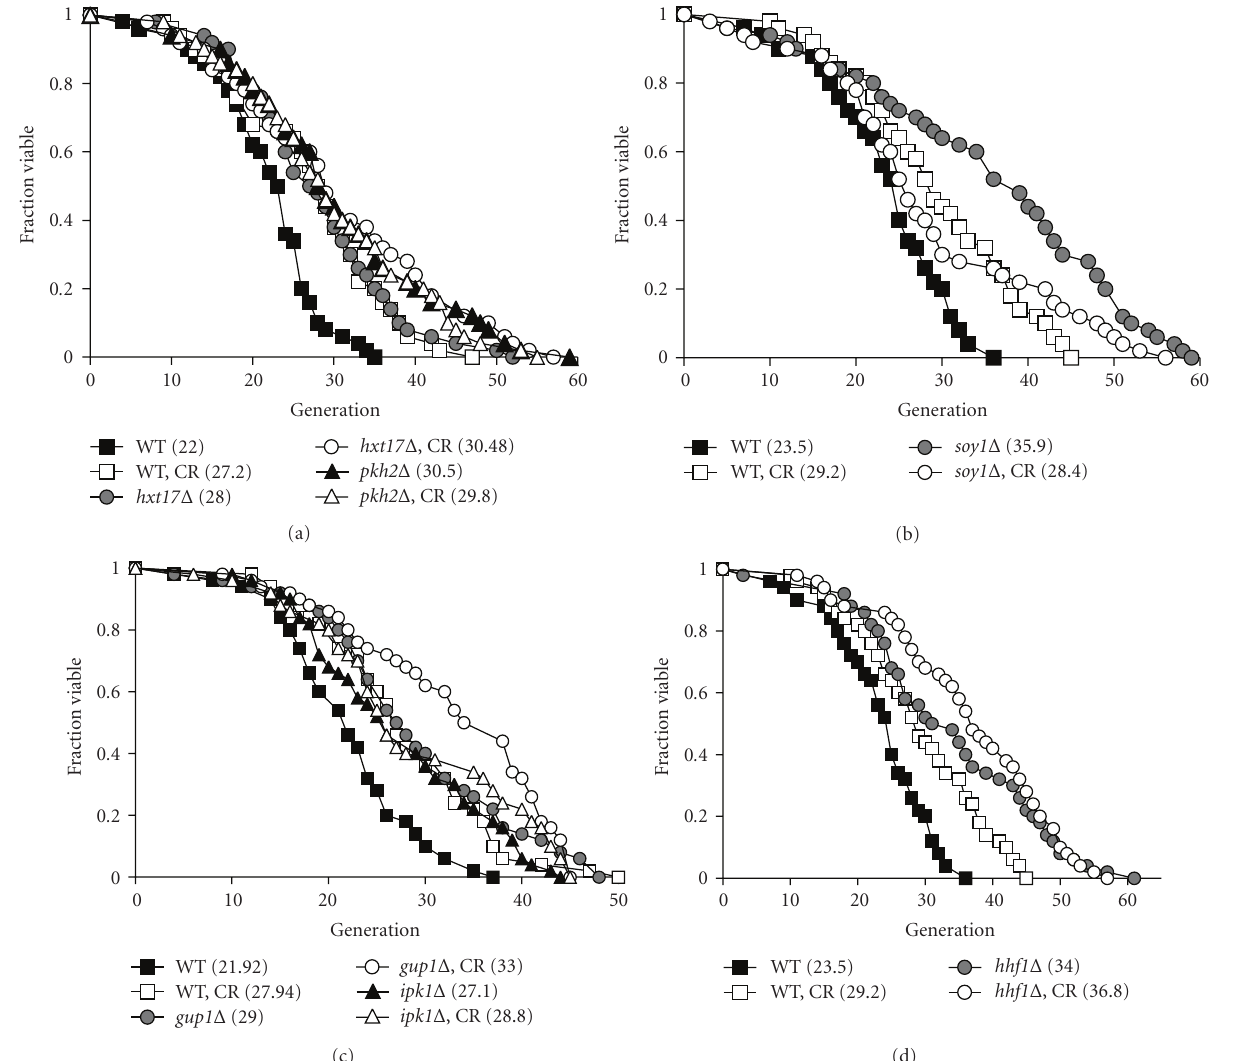
Figure 3: Replicative lifespan (RLS) analysis of potential CR genetic mimics. (a) Potential CR mimicking high-NO mutants show extended RLS and do not significantly further increase the RLS of cells grown in CR. (b) CR decreases soy1 Δ -induced RLS ( soy1 Δ versus soy1 Δ , CR; P = . 008); however, soy1 Δ does not significantly change CR-induced RLS (CR versus soy1 Δ , CR; P = . 49). (c) CR further increases gup1 Δ - induced RLS ( gup1 Δ versus gup1 Δ , CR; P = . 038). gup1 Δ also further increases CR-induced RLS (CR versus gup1 Δ , CR; P = . 004). (d) Although hhf1 Δ further increases CR-induced RLS (CR versus hhf1 Δ , CR; P = . 001), CR does not further increase hhf1 Δ -induced RLS ( hhf1 Δ versus hhf1 Δ , CR; P = . 19). One representative set of three independent experiments is shown. WT: BY4742 wild-type control; CR: 0.5% glucose; Δ : gene deletion. Pairwise statistical analysis of RLS is shown in Supplemental Table 3.